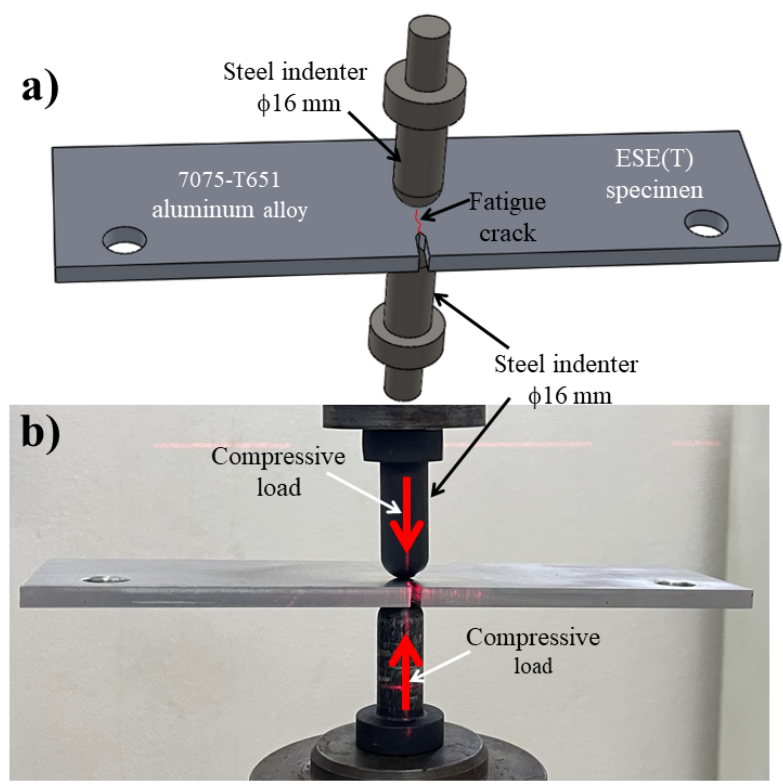
Figure 3. ( a ) Schematic configuration of the LCD process on 7075-T651 aluminum alloy ESE(T) specimen, ( b ) image taken during the LCD process.